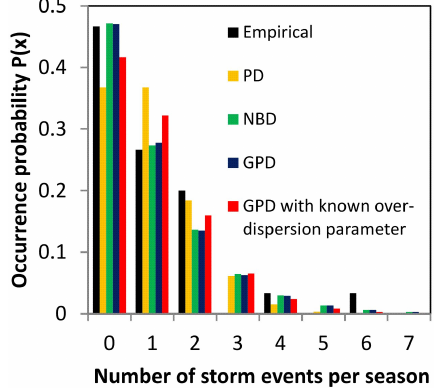
Figure 1. Relation between variance and expectation accord- ing to Eq. (6) with dispersion parameter β = 0.307 and corre- sponding behavior of dispersion statistics φ according to Eq. (5) (CRP = 1 /E(X) ).